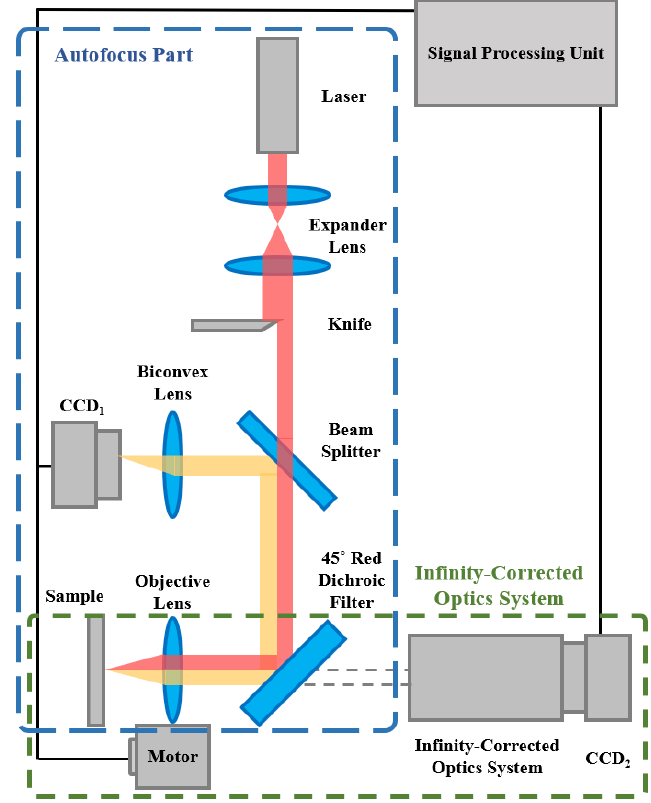
Figure 2. Structure of adopted autofocusing microscope.